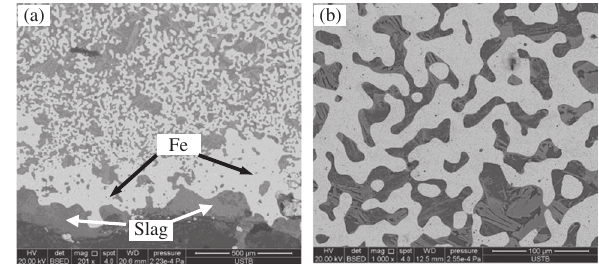
Figure 8: The microstructure of pellet with shrinkage rate at 60% in high reduction potential condition. (a) Granule structure; (b) microstructure.